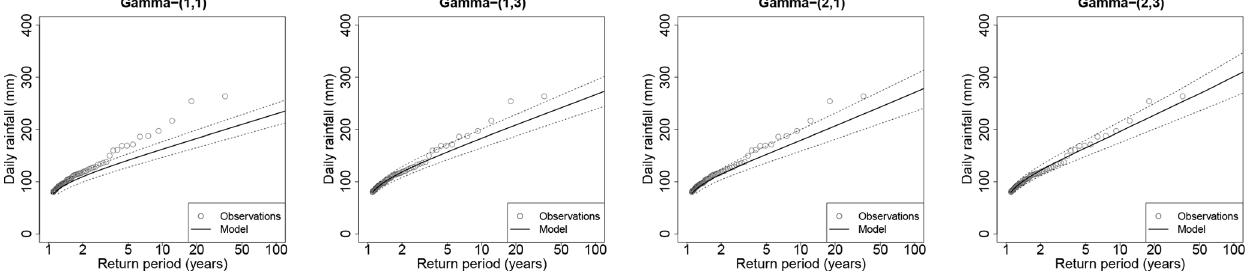
Figure 7. Case of Antraigues when G s,k are Gamma distributions and the number of seasons and WP varies: S ∈ { 1, 2 } and K ∈ { 1, 3 } . The values of ( S , K ) are indicated in the title. The dotted lines show the 95% envelope of return level estimates over the 100 subsamples. The plain line shows the median estimates. The gray points show the full sample (35 years). Each estimation is based on half of these points.